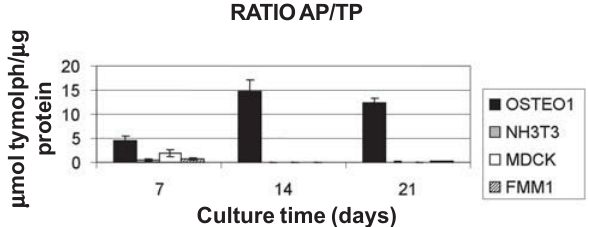
FIGURE 1- Alkaline phosphatase/total protein ratio ( µ mol thymolphthalein/ µ g protein) obtained for the four different cell types after 7, 14 and 21 days of culture. Data are reported as the mean ± standard deviation of one experiment performed in